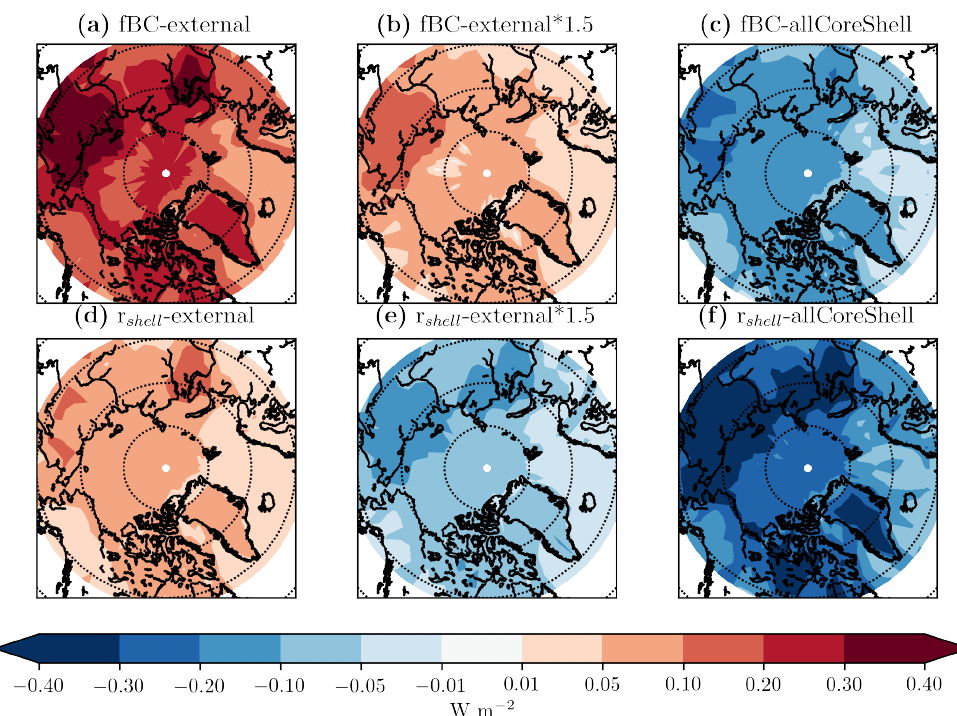
Figure 8. The difference in DRE between fBC-constrained (a, b, c) and r shell -constrained (d, e, f) compared to the bounding mixing-state